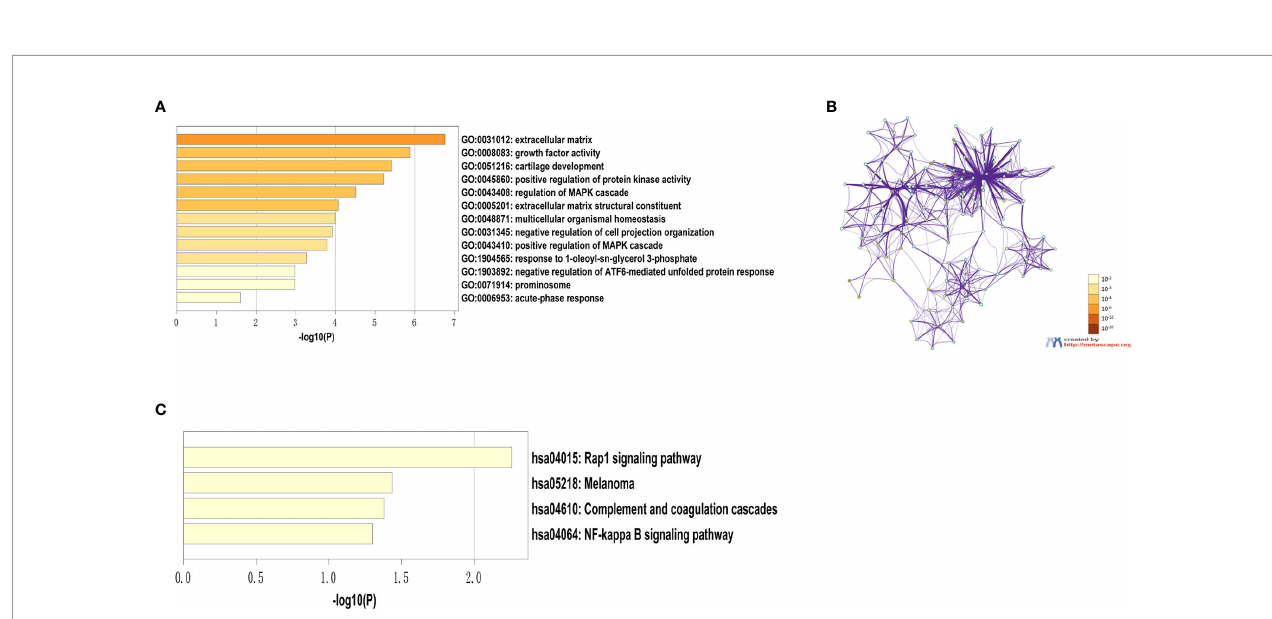
FIGURE 6 | Results of the hub gene GO and KEGG pathway analysis. (A) Top 13 GO enrichment terms. (B) A network of GO-rich terms colored by p-value. (C) Top nine KEGG pathway enrichment terms.